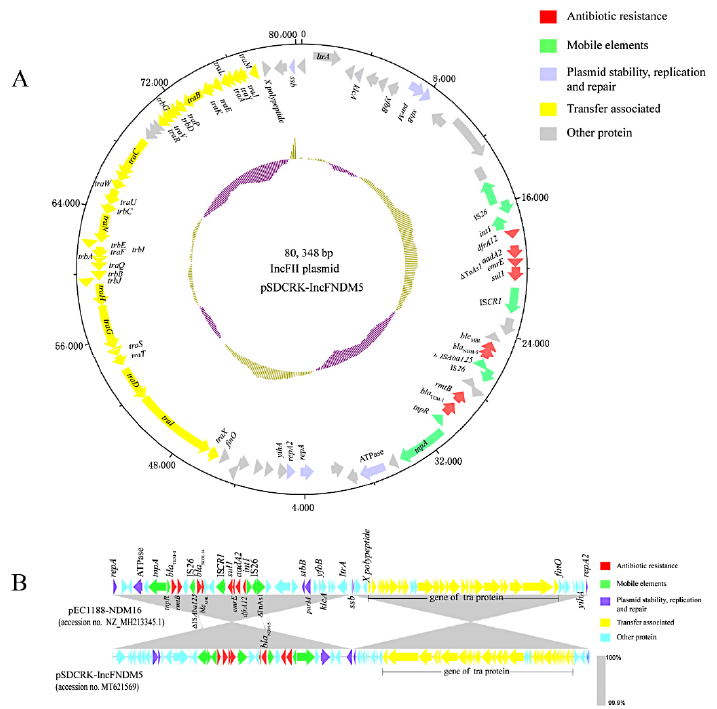
Figure 6. Schematic map of blaNDM-IncFII plasmid. Regions with ≥ 99.0% nucleotide sequence identity were shaded in gray. ( A ) Genetic environment of pSDCRK-IncFNDM5. ( B ) Comparative genomics of pSDCRK-IncFNDM5 and pEC1188-NDM16.